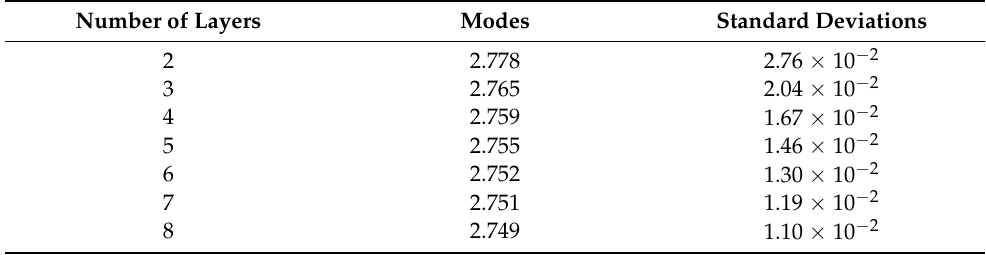
Table 6. Modes and standard deviations for the saturation density of 0.50 and the given number of layers.